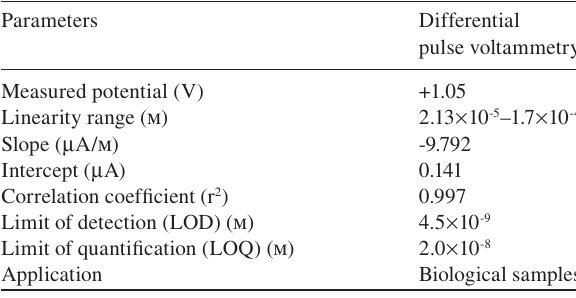
Table 1 Analytical parameters for voltammetry determination of gatifl oxacin using differential pulse